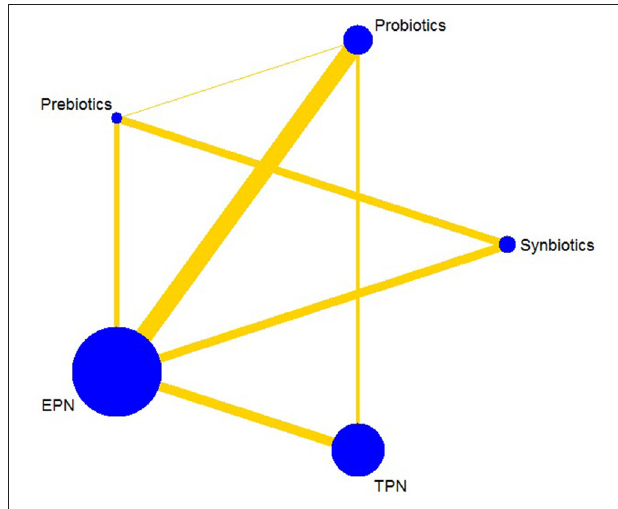
FIGURE 4 | Network plot of all intervention comparisons for nosocomial infection. The size of the nodes corresponds to the total number of participants that study the treatments. The (directly) comparable treatments are linked with a line. The thickness of the line corresponds to the standard error of trials that study this comparison. The colors of the line correspond to the quality of trials that study this comparison. Low risk of bias [green] , moderate risk of bias [yellow] . EPN, Enteral nutrition or adjuvant peripheral parenteral nutrition; TPN, Total parenteral nutrition.